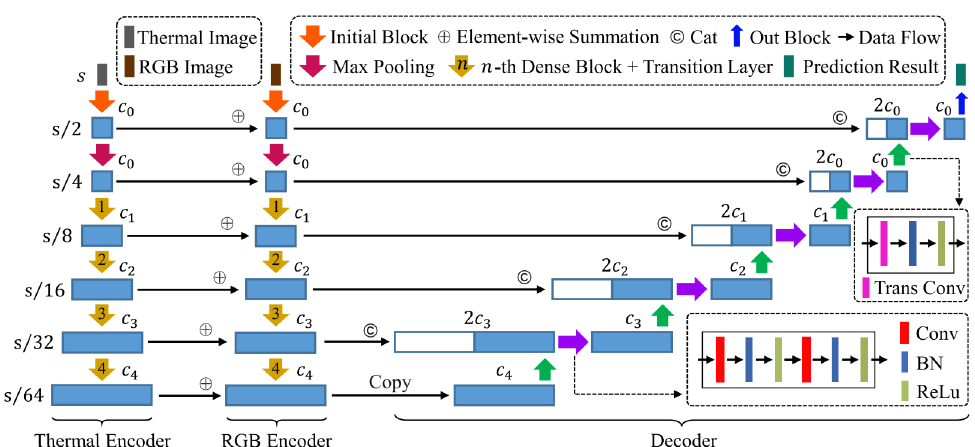
Figure 17. Figure from [117] showcasing the U-net-like architecture presented in the work. Reprinted with permission from the authors [117]. Copyright 2021,